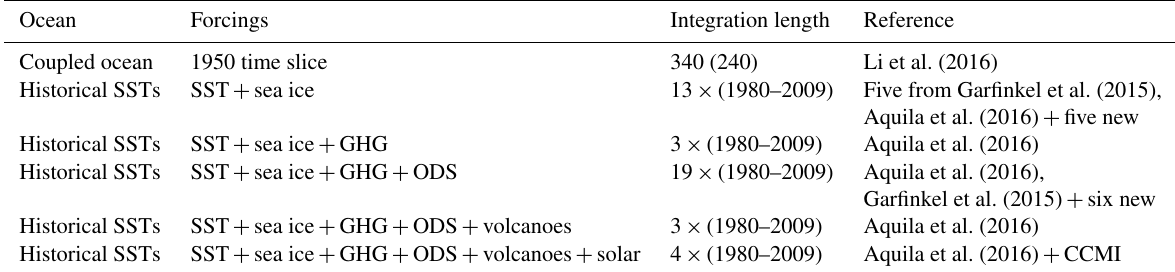
Table 1. GEOSCCM model experiments.